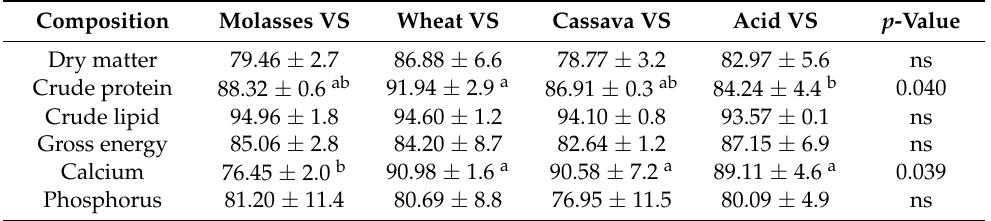
Table 5. Apparent digestibility coefficient of nutrients and energy of viscera silages for tambaqui juveniles (% dry